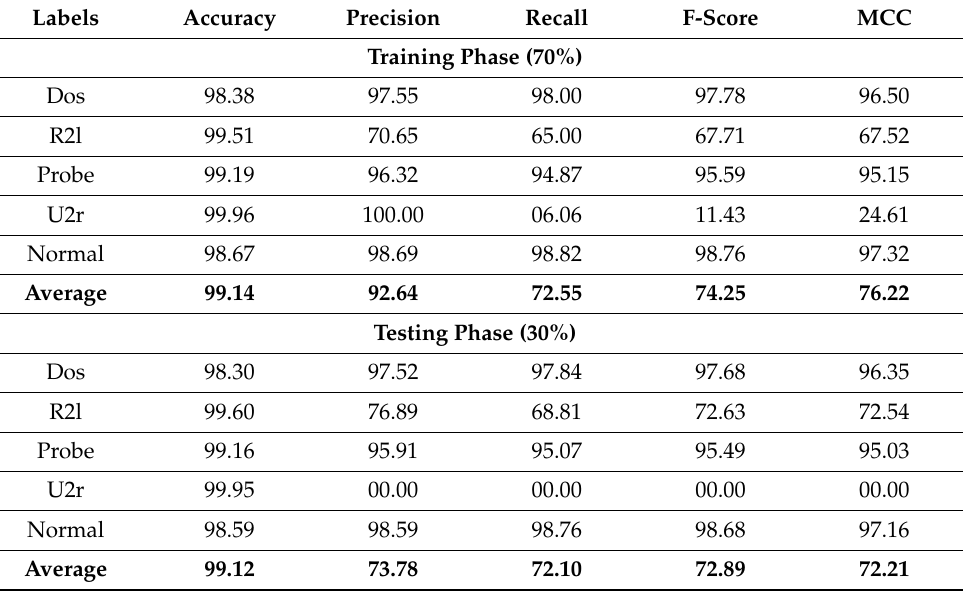
Table 3. Result analysis of FSHDBN-CID algorithm with distinct class labels under 70:30 of TR and TS